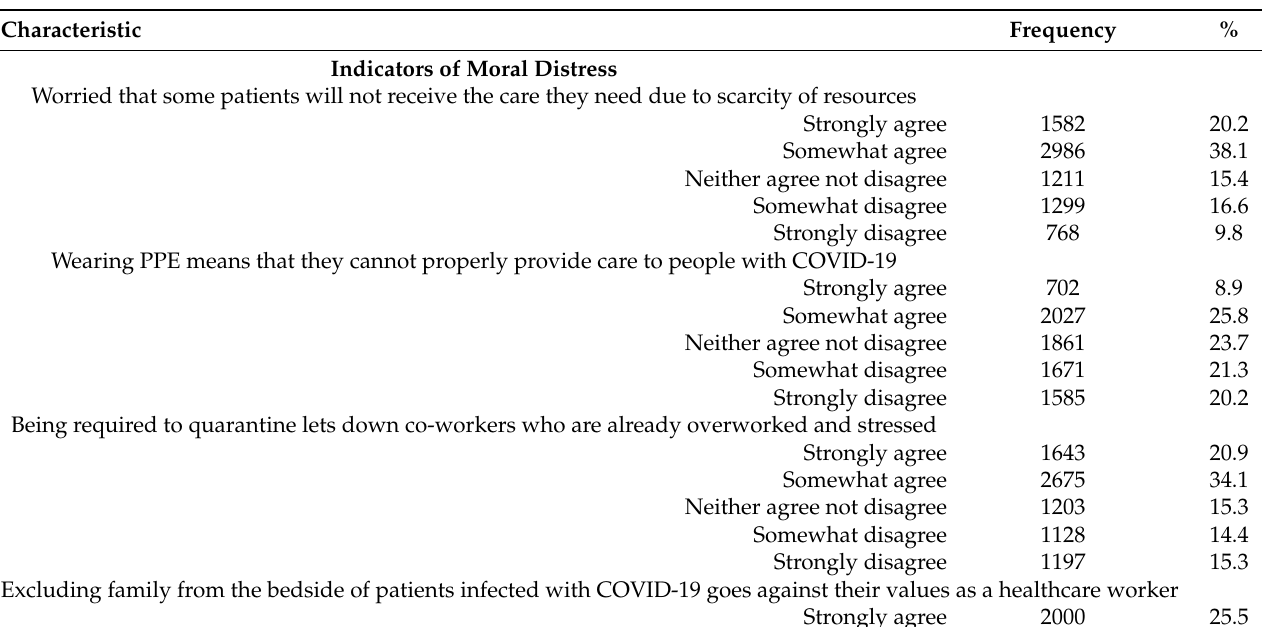
Table 2. Moral distress and perceived community views of healthcare